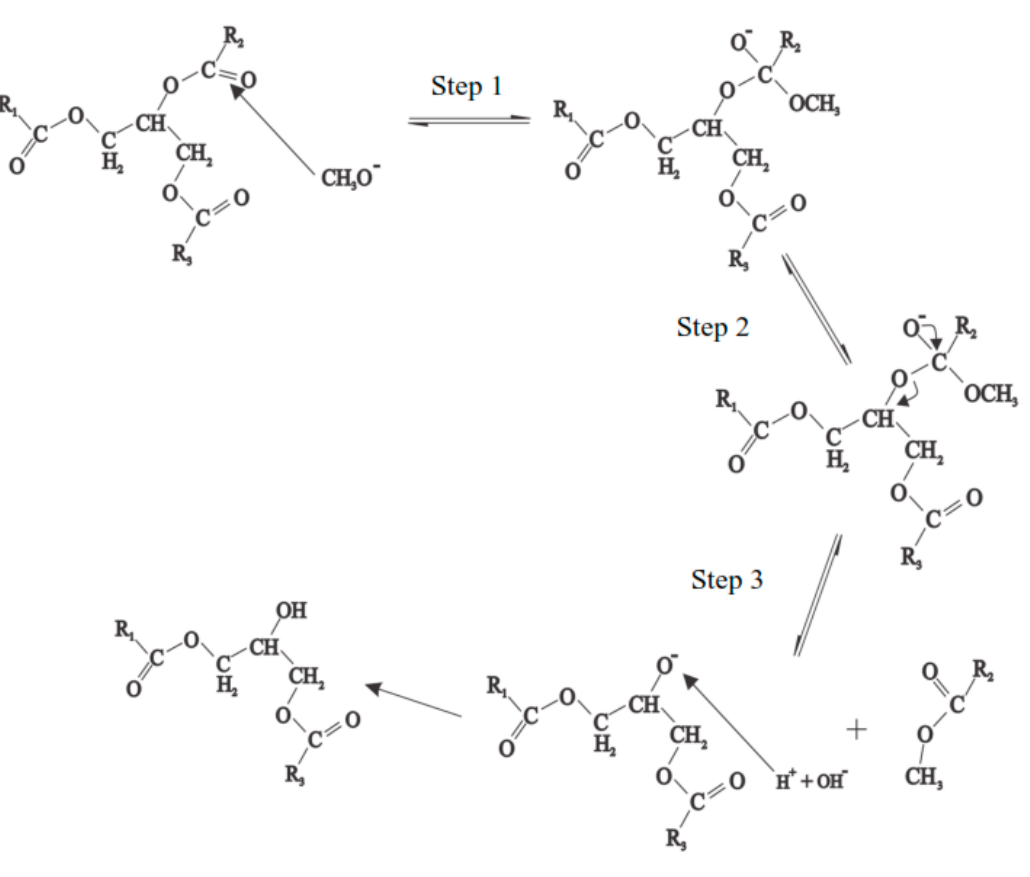
Figure 3. Triglyceride reaction with an alcohol.